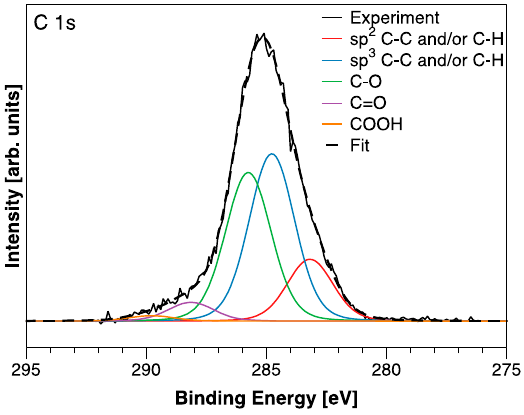
Figure 3. XPS spectrum of the a-C:H film deposited at 40 W RF power. Table 1. Summary of mechanical properties of a-C:H coating. Power (W)